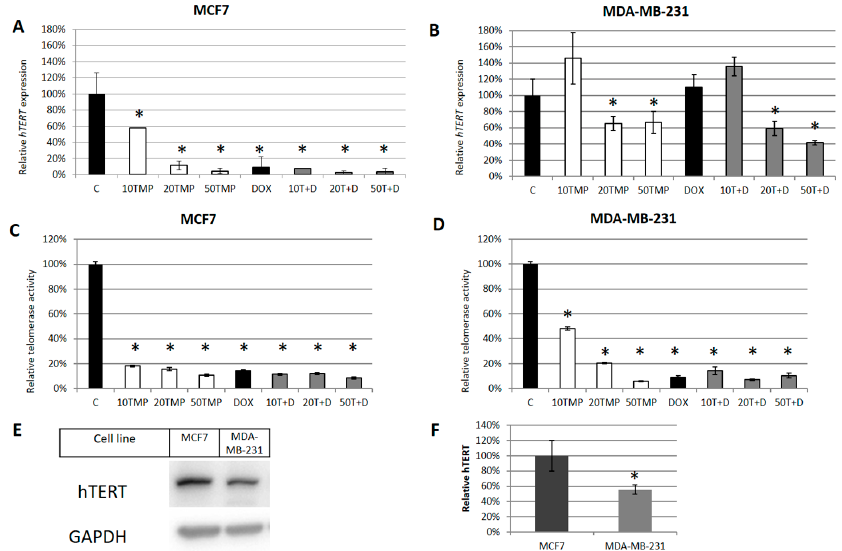
Figure 2. TMPyP4 alters telomerase expression and activity. The contribution of TMPyP4 to telomerase expression in MCF7 ( A ) and MDA-MB-231 cells ( B ) was assessed using qPCR.